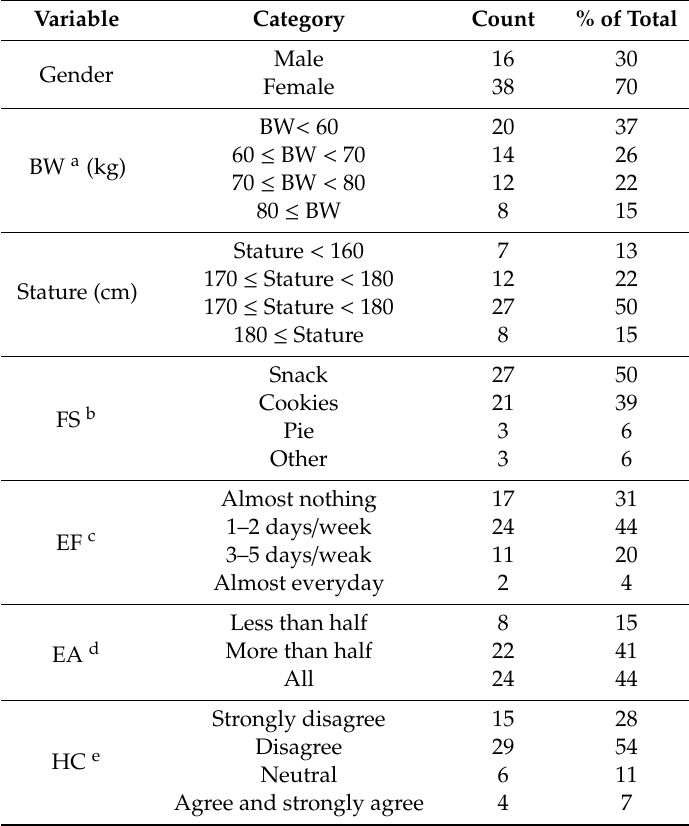
Table 1. Characteristics of participants’ body and snack